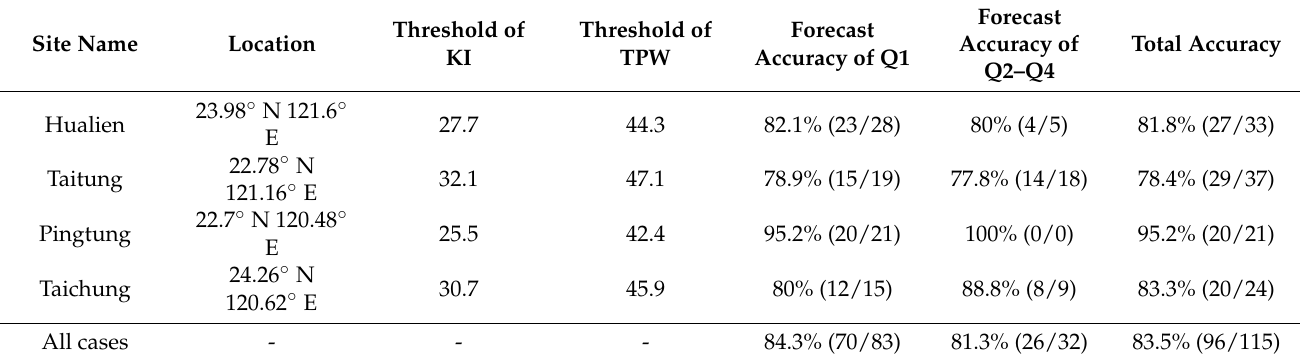
Table 6. KI and TPW thresholds and forecast accuracy at the four